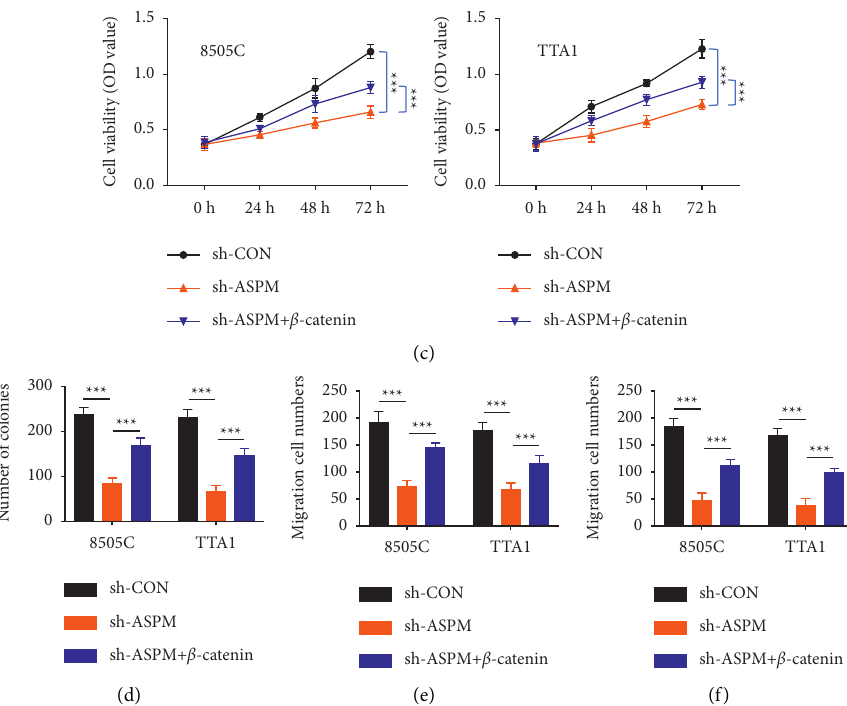
Figure 4: ASPM regulates the Wnt/ β -catenin signaling pathway in ATC cells. (a) Wnt3a was detected by TOPFlash assay, and several representative targets of Wnt signaling (CCND1, c-Jun, MMP7, and c-MYC) were evaluated using western blotting. (b) The expression of β -catenin in ATC cells after co-transfection with sh-ASPM and human β -catenin plasmids. (c–f) Cell proliferation, migration, and invasion were re-evaluated after the rescue of β -catenin. ∗∗ P < 0 . 01, ∗∗∗ P < 0 . 001.